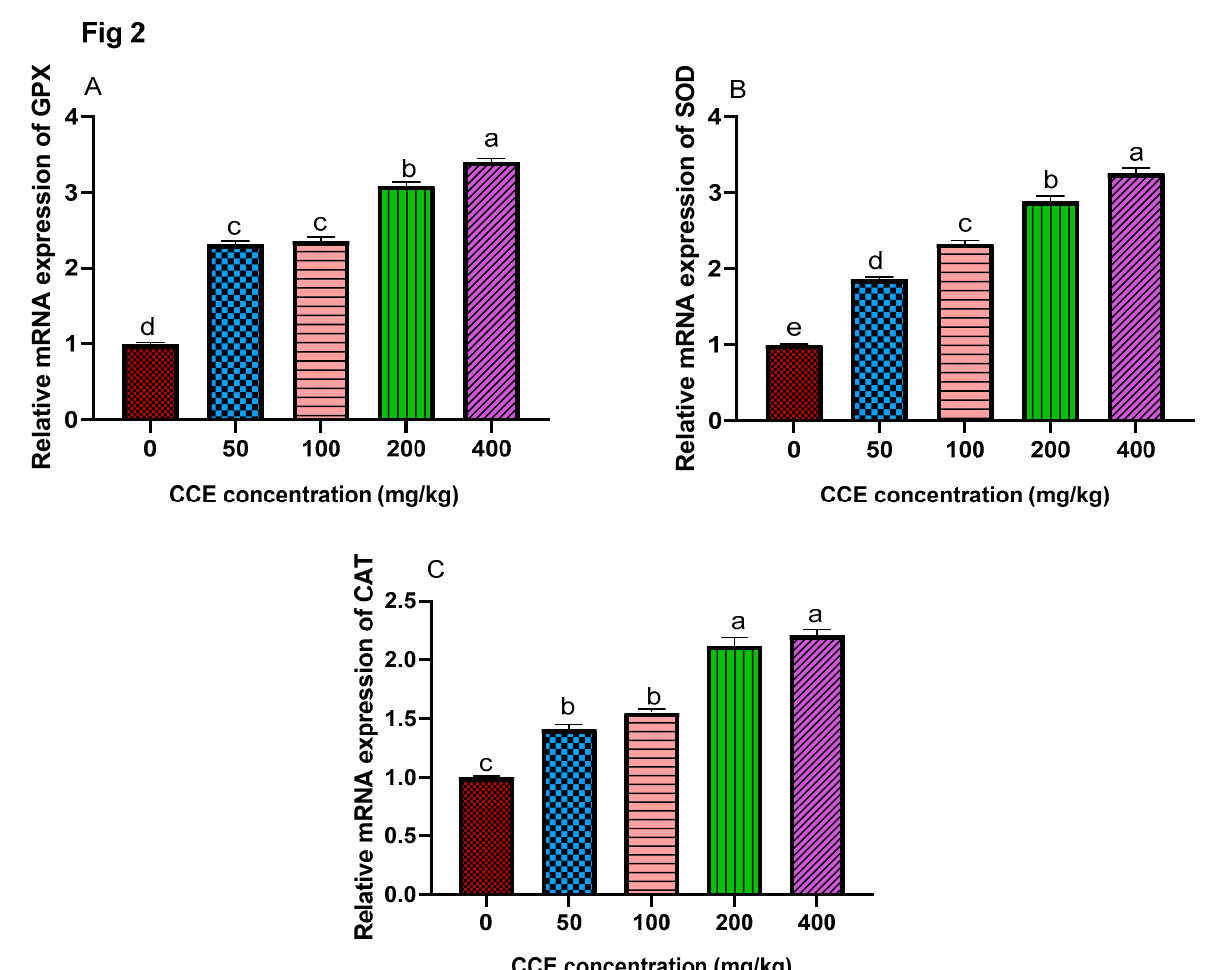
Figure 2. Effect of different levels of cornelian cherry extract ( CCE ) on (glutathione peroxidase, ( GPx ) ( A ), superoxide